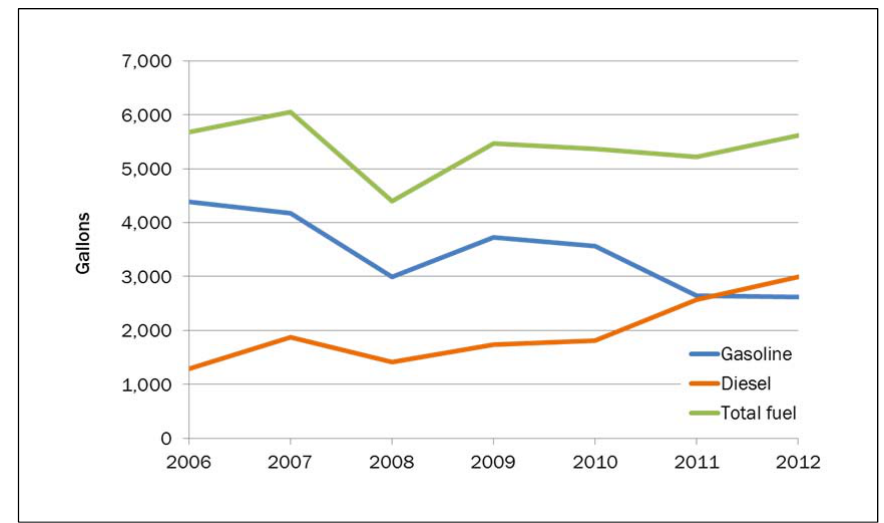
Figure 5. Fuel Use on the Berea College Student Farm,